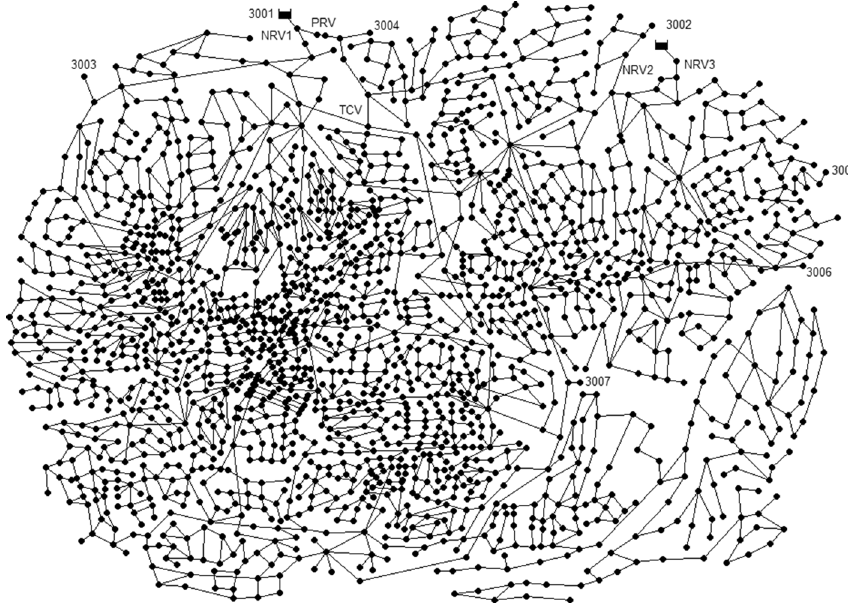
Fig. 8 WDS benchmark for PRV localization (Farmani and Walters 2004)